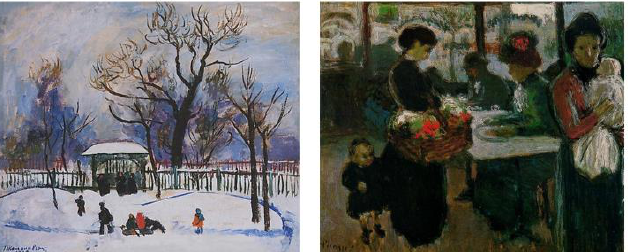
Table 5. Results with respect to the utilized image-to-emotion